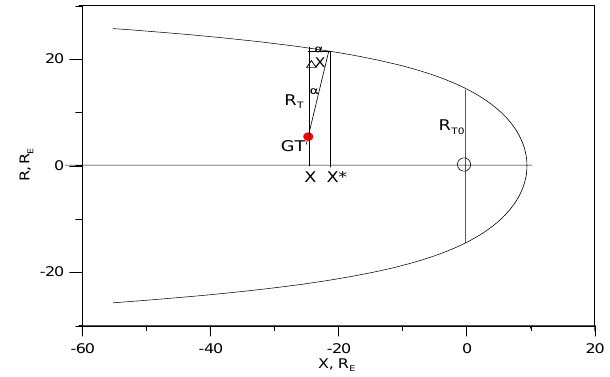
Fig. 1. The scheme, presenting the geometry of Geotail measure- ments. X is the Geotail position, X ∗ is the magnetopause coordi- nate, corresponding to the same B L and α values, R T is the tail